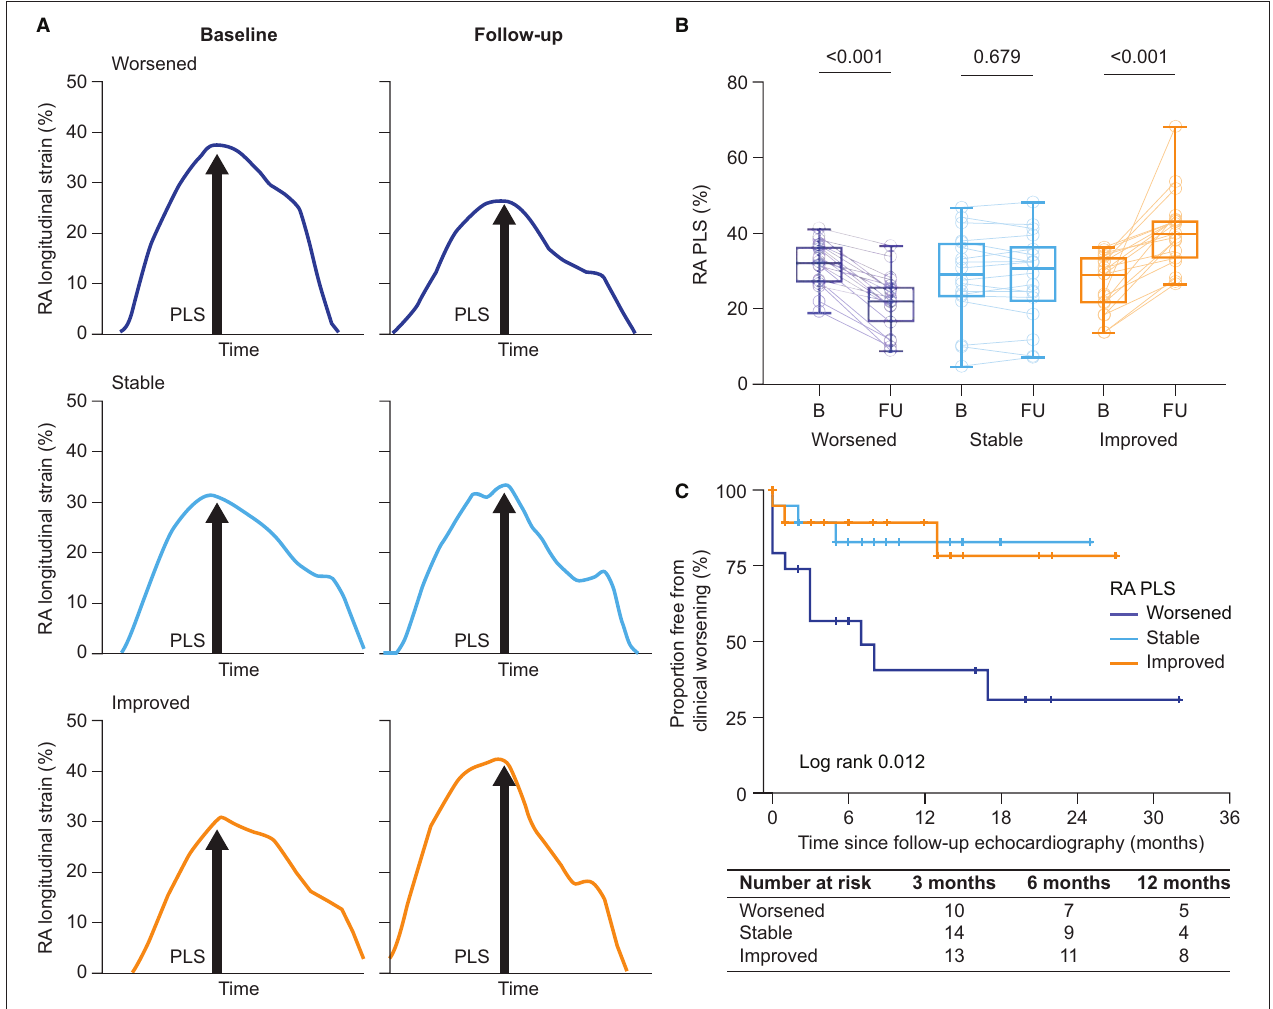
FIGURE 3 | Longitudinal RA function. (A) Illustration of the assessment of RA phases at baseline and during follow-up according to the change in RA function (worsened, stable, and improved). Stratification was based on tertile of absolute change of RA PLS and RA PACS. (B) RA PLS stratified by tertile of absolute change [tertile I (worsened): 1 − 17.8% to − 4.2%; tertile II (stable): 1 − 4.2% to 4.0%; and tertile III (improved): 1 4.0% to 44.6%]. Box-plots show median, interquartile range, and minimum to maximum values. (C) The Kaplan–Meier plots of time to clinical worsening since follow-up echocardiography stratified by RA function based on RA PLS. RA, right atrial; PACS, peak active contraction strain; PLS, peak longitudinal